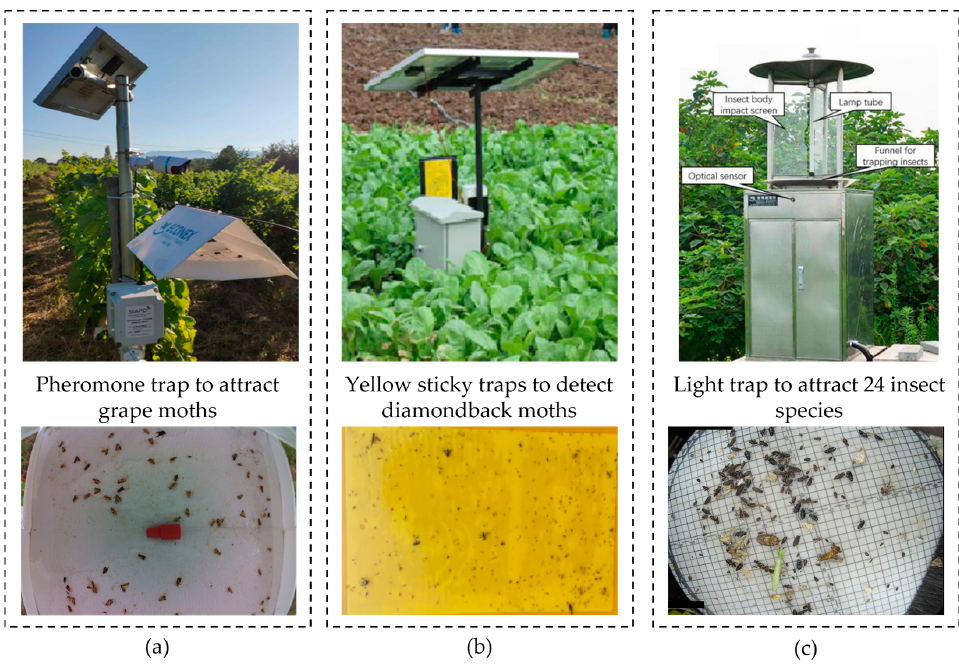
Figure 1. Devices installed in the field to collect images of traps and the respective images collected. ( a ) Pheromone trap in a vineyard to attract grape moths provided by [22]; ( b ) yellow sticky traps installed to detect diamondback moths adapted from [23]; ( c ) light trap to attract 24 major pest classes specified by the Chinese Ministry of Agriculture. Images adapted from the dataset Pest24 [24].